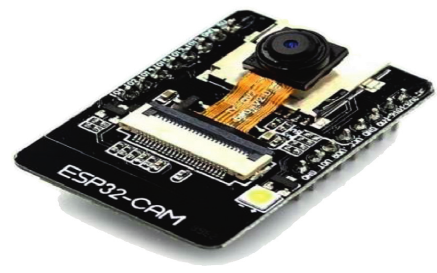
Figure 7: ESP32-CAM.